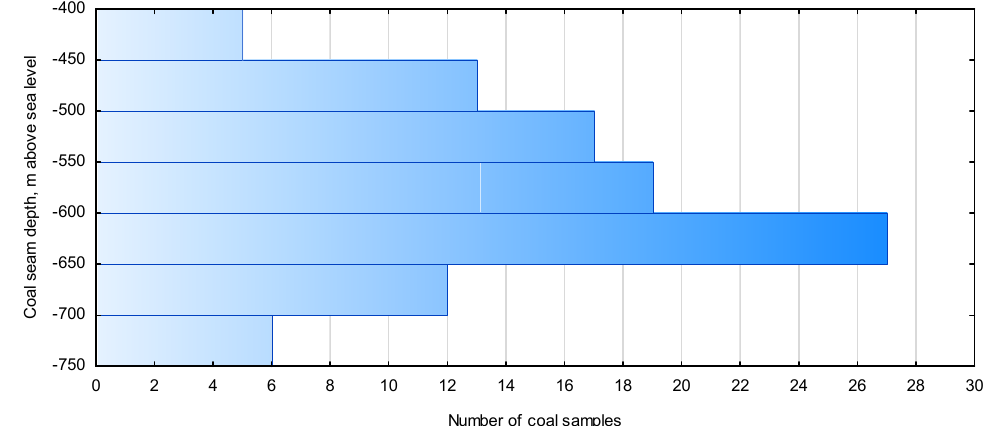
Figure 3. Histogram showing the number of samples taken for the tests in individual intervals of coal seam depth.